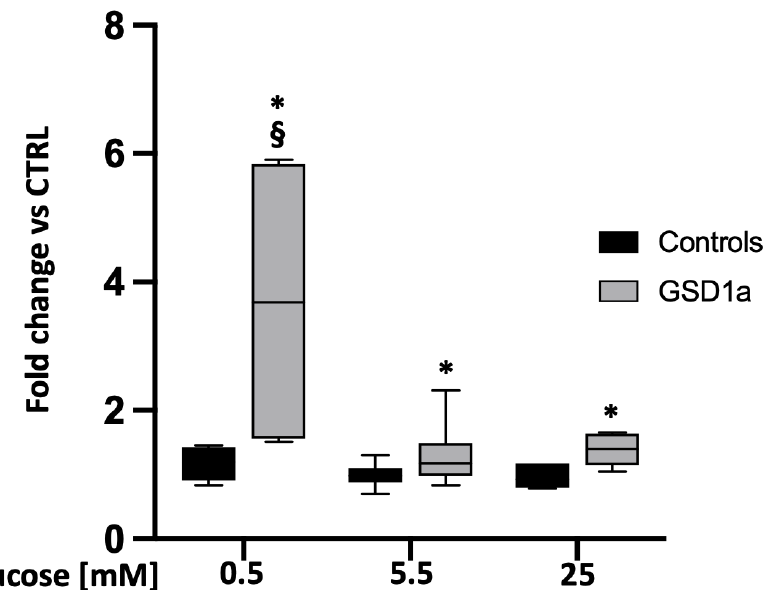
Figure 3. Quantification of reactive oxygen species (ROS) levels in URECs from GSD1a patients ( n = 3) and control subjects ( n = 3). ROSs were measured after 24 h of incubation of cells at different glucose conditions: low (0.5 mM), physiological (5.5 mM), and high (25 mM) glucose concentrations. The values obtained are reported as the mean ± SD of at least 3 technical replicates. Statistical significance was verified by unpaired t -test. * p < 0.05 GSD1a cells vs. control cells; § p < 0.001 GSD1a cells at low glucose (0.5 mM) vs. GSD1a cells at physiological (5.5 mM) and high (25 mM) glucose.